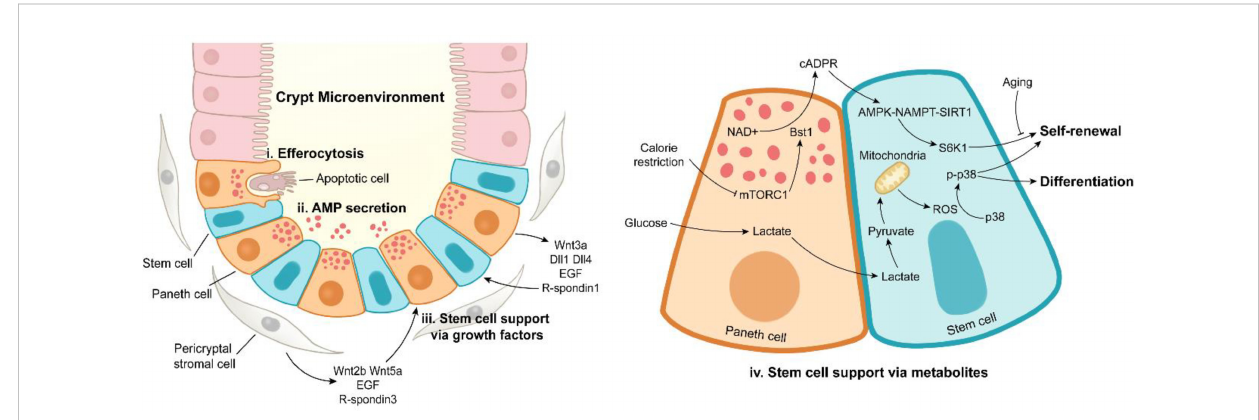
FIGURE 3 Paneth cell functions under intestinal homeostasis. Paneth cells maintain the stabilization of crypt microenvironment via efferocytosis of apoptotic cells (i), antimicrobial peptide secretion (ii), stem cell support by releasing growth factors (iii) or metabolites (iv). In addition to Paneth cells, pericryptal stromal cells are another important source of growth